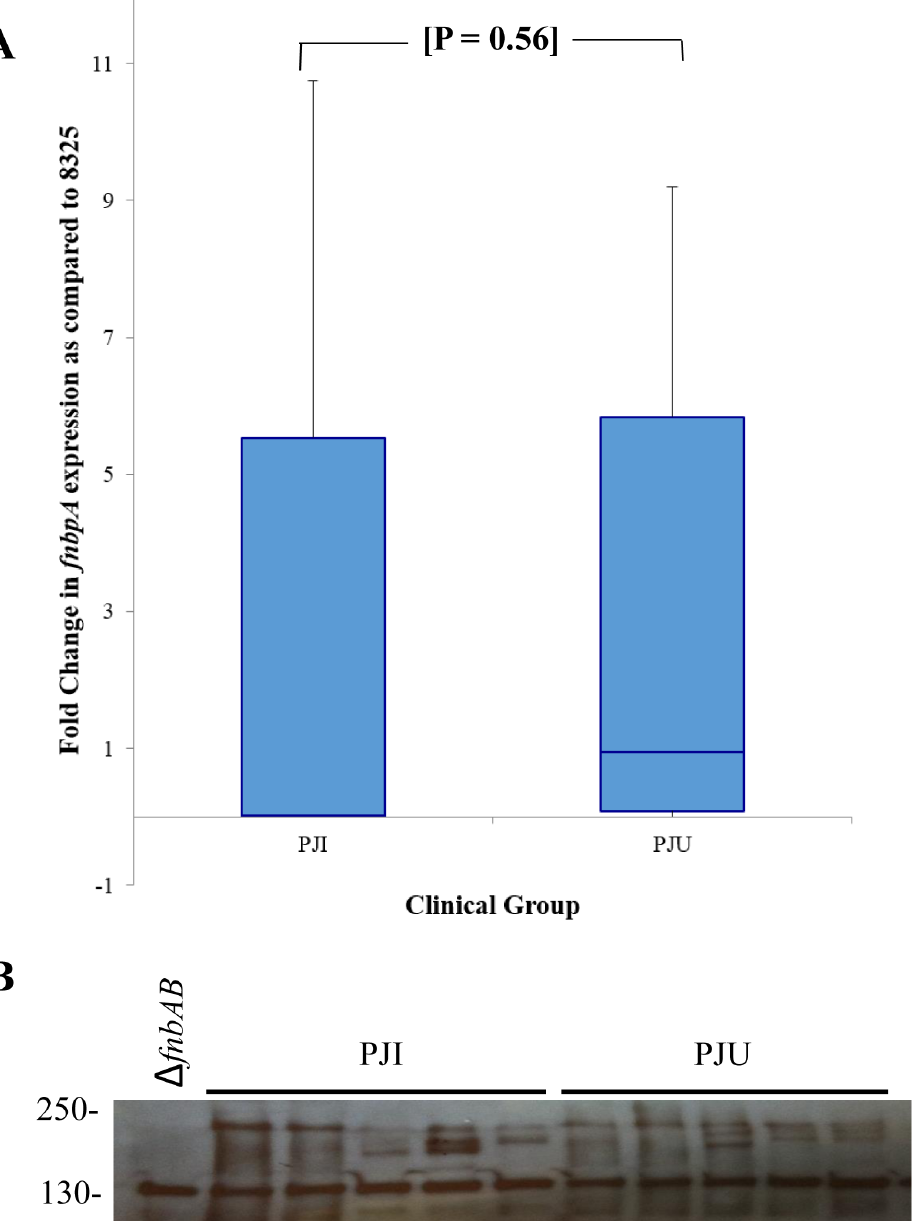
Fig 6. Fibronectin binding protein A ( fnbA) RNA expression (A) and fibronectin binding proteins (FnBPs) expression (B) in randomly selected S . aureus bloodstream isolates from patients with infected (PJI) and uninfected (PJU) prosthetic hip or knee joints. (A) RNA expression is represented as percent fnbA expression relative to S . aureus control 8325 – 4. Box ends represent the 25 th and 75 th percentiles, and whisker ends represent the minimum and maximum. There is no significant difference in fnbA expression between the two groups. (B) Fibronectin-binding protein expression was determined with Western ligand affinity blotting. There is no major difference in expression between the two clinical groups. Protein size (kilodaltons) is displayed and the double mutant fnbAB is included as a